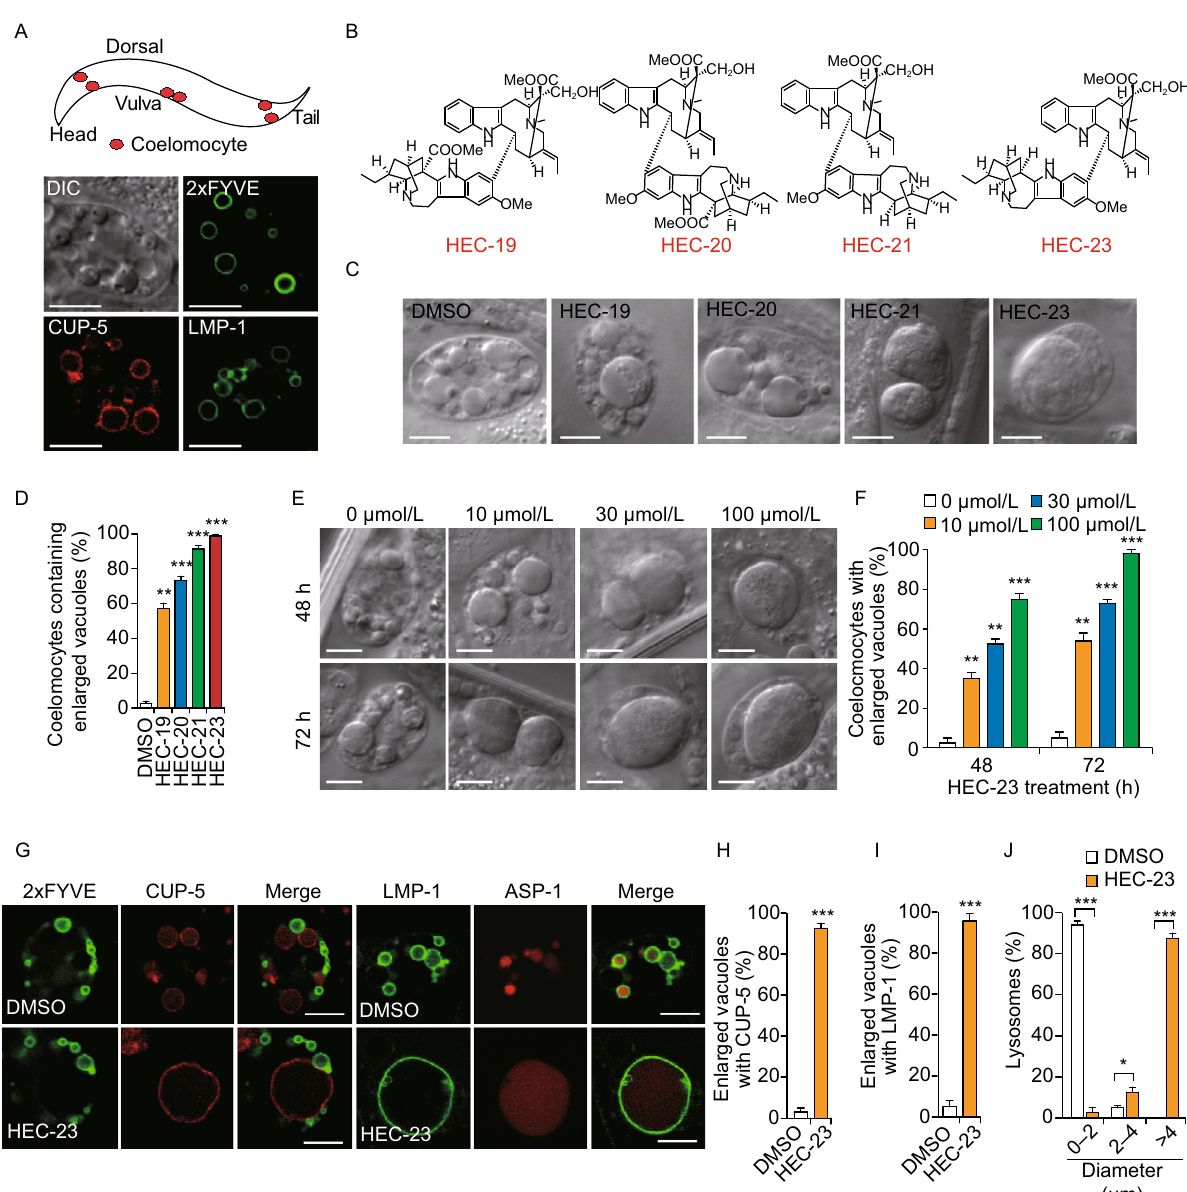
Figure 1. HEC-23 induces lysosomal enlargement in coelomocytes. (A) Representative images of endosomes and lysosomes in C . elegans coelomocytes. The top panel shows a schematic depiction of 3 pairs of coelomocytes (in red) in C . elegans. The bottom panels show a DIC image of a coelomocyte and images of 2xFYVE::GFP-labeled early endosomes, mCherry::CUP-5-labeled lysosomes, and LMP-1::GFP-labeled lysosomes. Scale bars, 10 μ m. (B) Structures of HEC family compounds. (C and D) HEC family compounds induce enlargement of vacuoles in coelomocytes. Worms were treated with indicated HEC compounds at 100 μ mol/L for 48 h. DIC images (C) are shown for the vacuoles and quanti fi cations are shown in (D). (E and F) Representative DIC images (E) and quanti fi cation (F) of vacuole enlargement induced by HEC-23. (G) Effect of HEC-23 on vacuoles positive for 2xFYVE::GFP, mCherry:: CUP-5, LMP-1::GFP and ASP-1::dsRed. Scale bars, 10 μ m. (H and I) Quanti fi cation of vacuoles labeled with mCherry::CUP-5 (H) and LMP-1::GFP (I) in animals treated with HEC-23. (J) Quanti fi cation of lysosome sizes in worms treated with HEC-23 (100 μ mol/L, 48 h). Data (mean ± SEM) were from 3 independent experiments. ** P < 0.01, *** P <